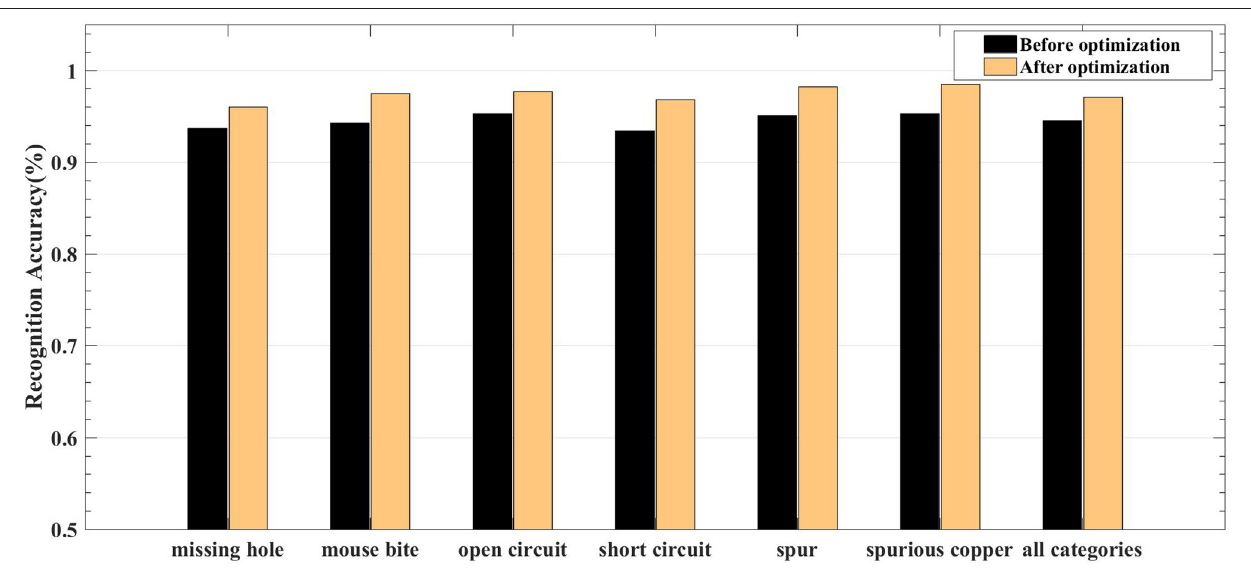
FIGURE 6 | The recognition accuracy of different minor defects.